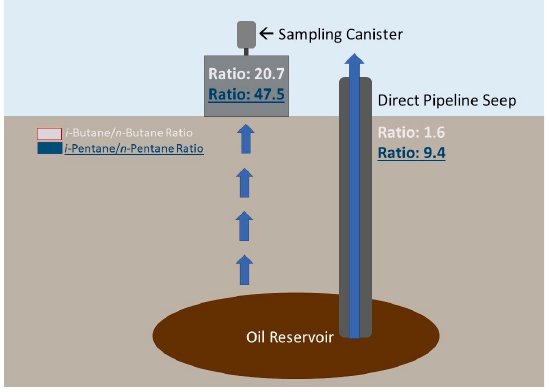
Figure 6. Cartoon showing anthropogenic influence on i / n gas ratios at Carpinteria.